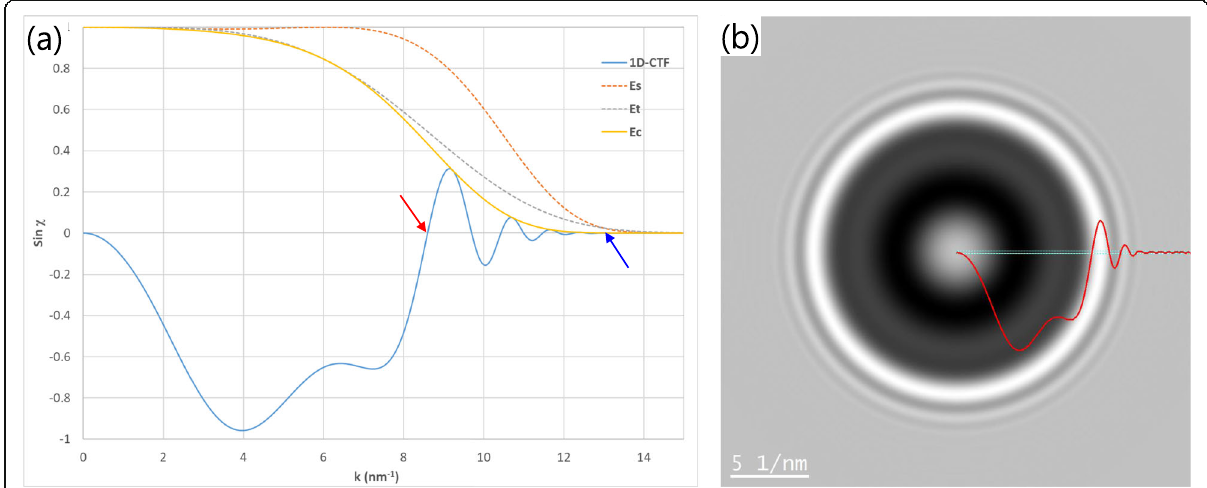
Fig. 2 CTF calculation results of a HVEM operating at 1250 kV. a Results for 1D-CTF obtained by editing the saved calculation result spreadsheet. The red arrow indicates the Scherzer cutoff frequency, i.e., the point resolution of the simulated TEM, and its value is 8.6 nm − 1 (0.116 nm), while the blue arrow indicates the corresponding information limit with a value of 12.44 nm − 1 (0.08 nm). b Corresponding saved 2D-CTF images obtained using the CTF simulator. The inset line profile in the 2D-CTF image is identical to the 1D-CTF result